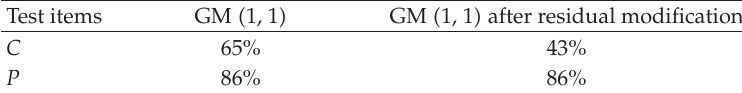
Table 2: Comparison of model’s accuracy.